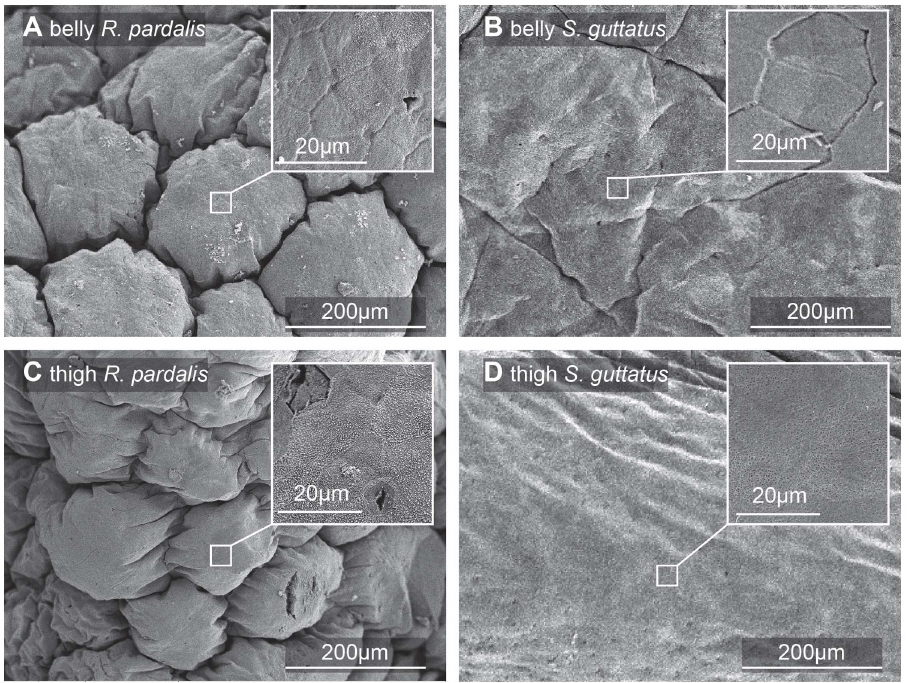
Figure 7. Scanning electron micrographs of ventral body skin. Belly (A,B) and ventral thigh epithelium (C,D) of the tree frog ( R. pardalis , left column) and the torrent frog ( S. guttatus , right column). Insets show structures at higher magnification.